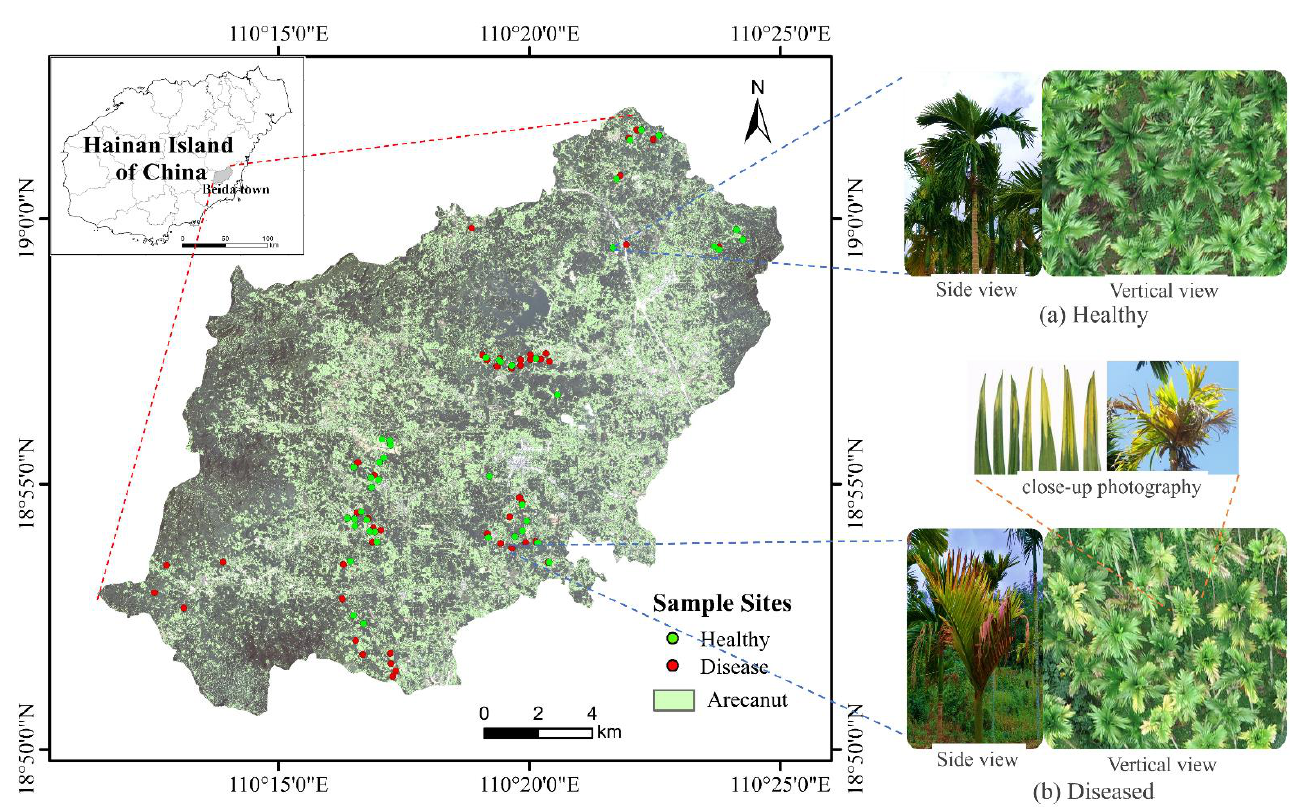
Figure 1. Location of the study area with the distribution of survey sample sites, and coordinate system using WGS84 , ( a ) Side view and vertical view of healthy arecanut; ( b ) Side view and vertical view of diseased arecanut.